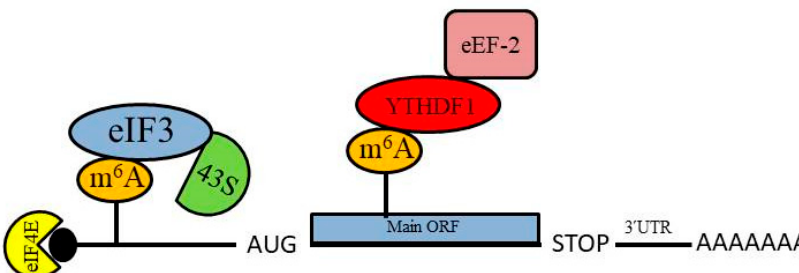
Figure 2. Overview of the role of N 6 -methyladenosine (m 6 A) modification of mRNA in protein synthesis. m 6 A modification of mRNA within the 5 ʹ untranslated region (5 ʹ -UTR) permits direct